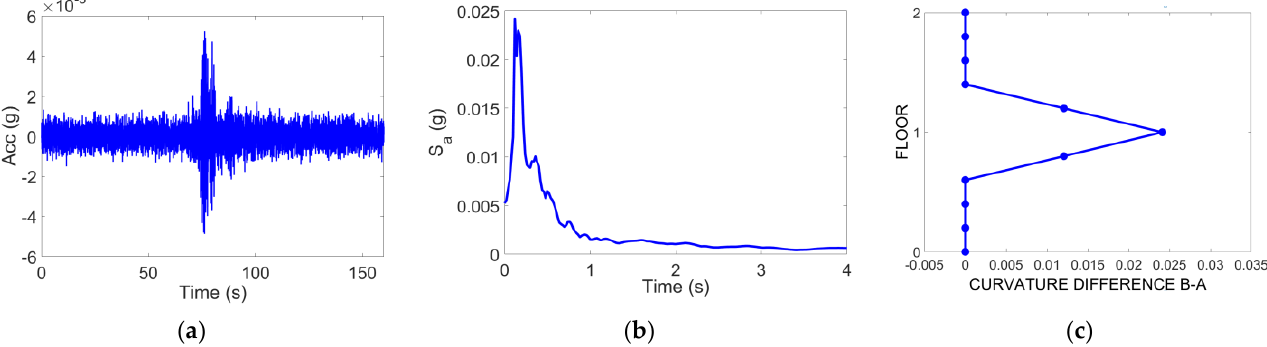
Figure 24. Results for the event that occurred on 9 April 2009 at 03:14: ( a ) ground accelerometric recordings; ( b ) response spectrum; ( c ) curvature differences between the selected time-instants B and A.